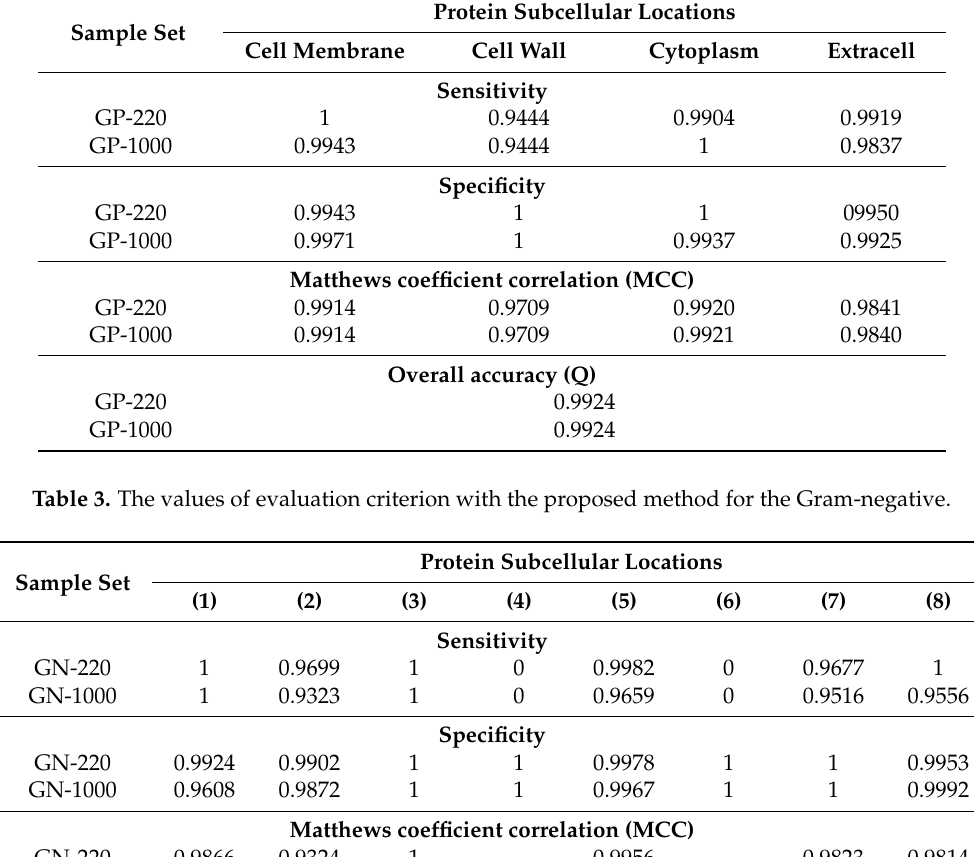
Table 2. The values of evaluation criterion with the proposed method for the Gram-positive.